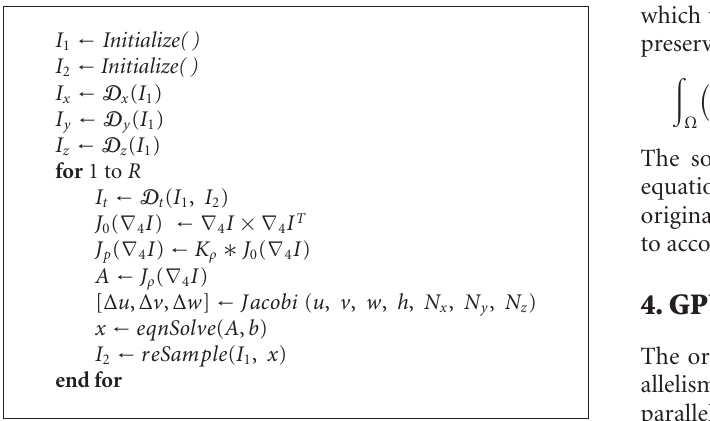
Algorithm 1: The estimation algorithm without the volume preserving term (see Section 3.3. The meanings of the symbols remain as in the text. I 1 represents a static image I ( x , y , z , t )